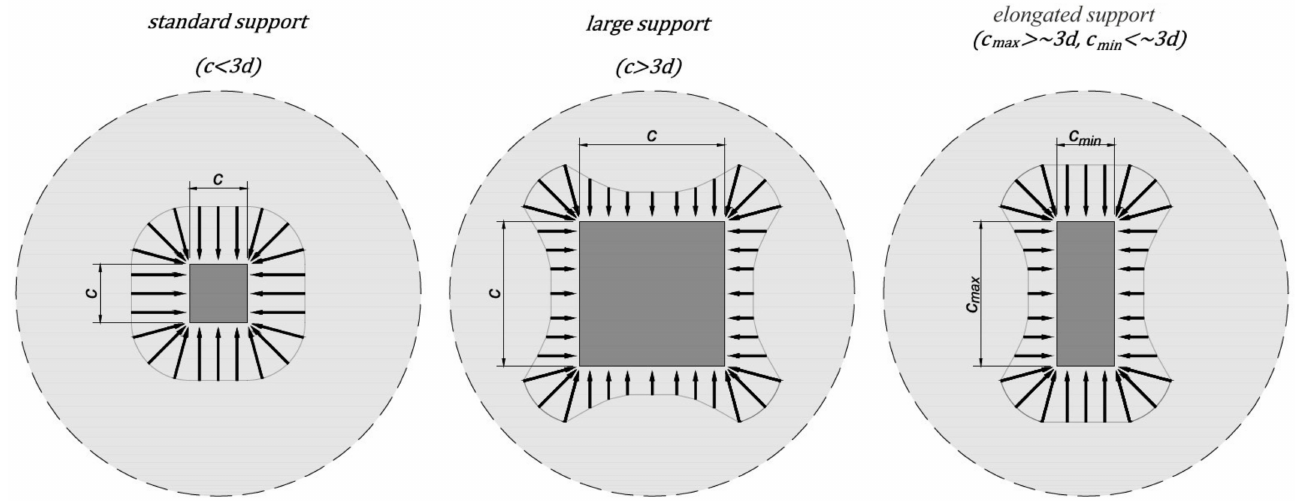
Figure 2. Distribution of shear forces in the vicinity of internal support as a function of its size and